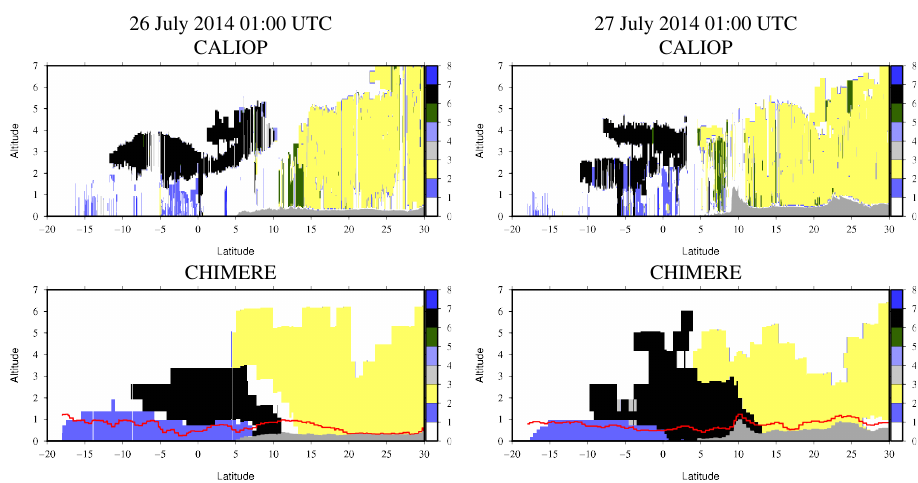
Figure 8. Vertical cross section of CALIOP aerosol types and comparison to the CHIMERE FIRE simulation. The colour bar is related to the CALIOP classification: (0:1) not applicable, (1:2) clean marine, (2:3) dust, (3:4) polluted continental or smoke, (4:5) clean continental, (5:6) polluted dust, (6:7) elevated smoke, and (7:8) dusty marine. For the model, the boundary layer height is superimposed in red.